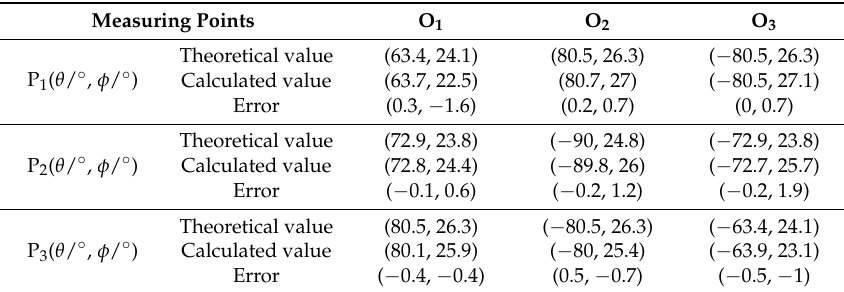
Table 4. The separation and localization results by the proposed method with different SNRs. SNR/dB